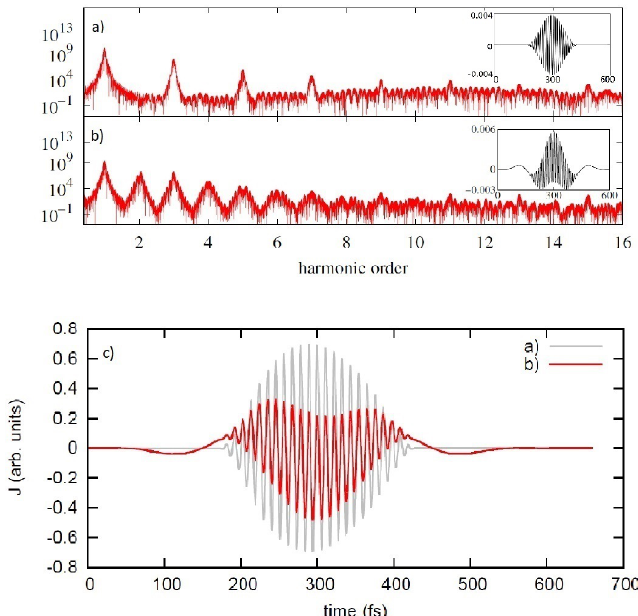
Figure 6. The appearance of even-order harmonics. Panel ( a ) infrared excitation, panel ( b ) THz assisted infrared excitation. The time dependences of the vector potentials of the exciting fields are shown by the insets, where the units for the horizontal and vertical axes are fs and GV · fs / m, respectively. Panel ( c ) shows the current density J , which is the source of the HH radiation.